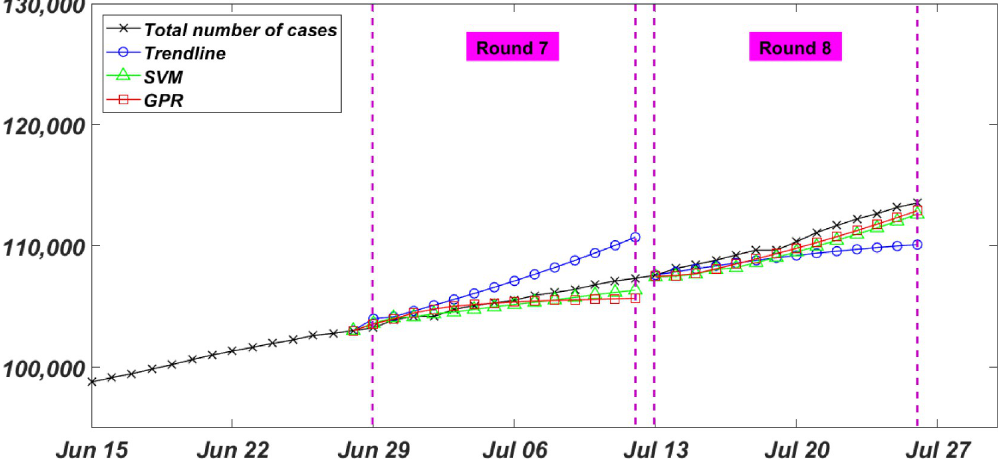
Fig 7. Rounds 7 and 8 of the bi-weekly total number of infected COVID-19 cases in Canada.